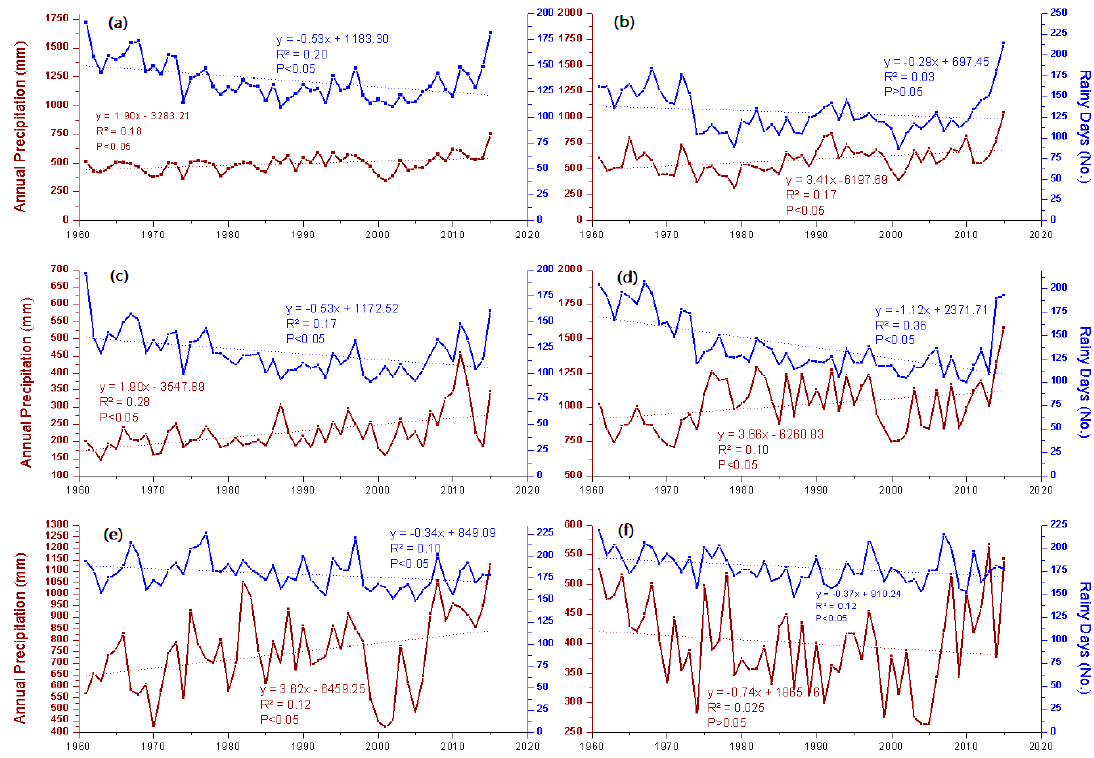
Figure 7. Time series of annual precipitation and rainy days ( a ) Source region of the Indus River, ( b ) Kabul sub-basin, ( c ) Upper Indus sub-basin, ( d ) Jhelum sub-basin, ( e ) Chenab sub-basin, ( f ) Satluj sub-basin.